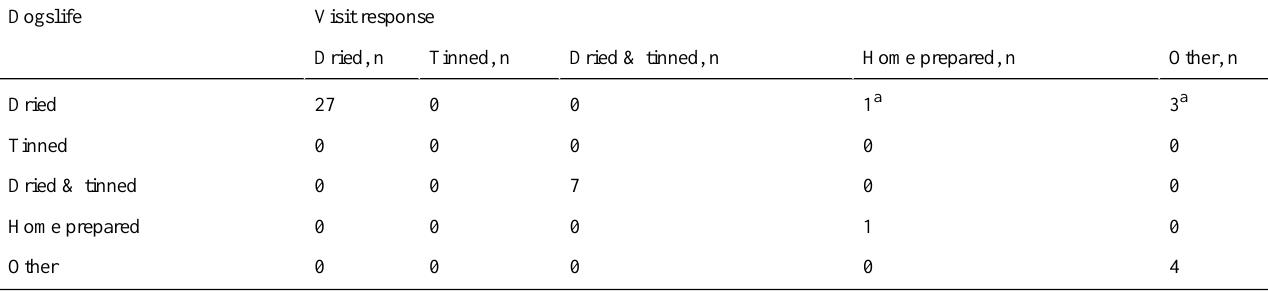
Table 3. Comparison of food types in Dogslife record with visit response. Numbers entered refer to the count of households. Visit